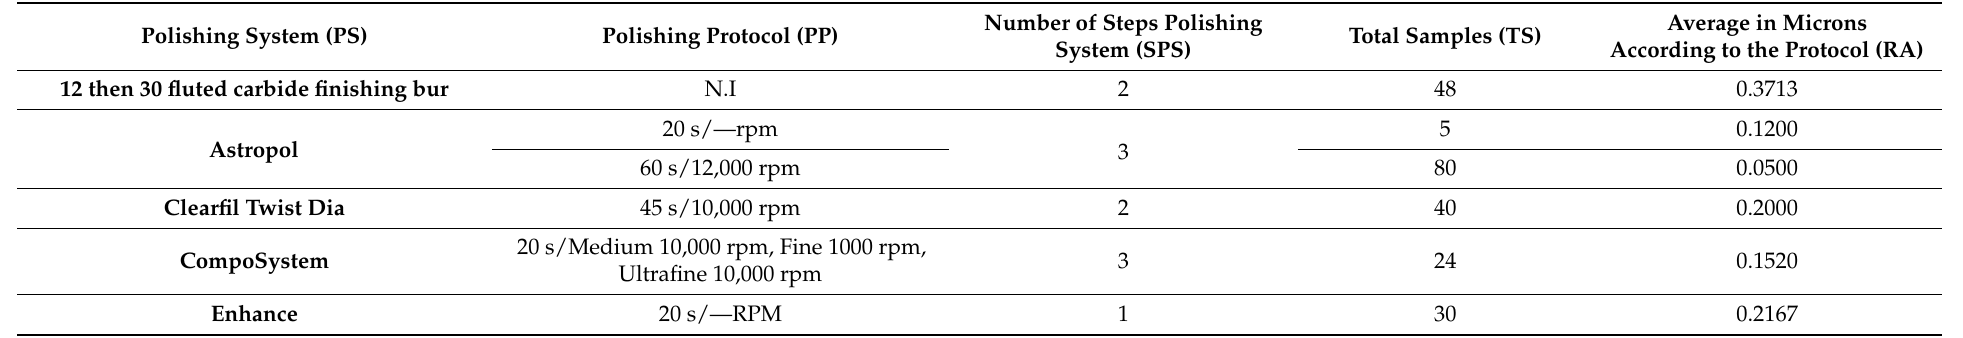
Table 3. Summary of the polishing protocols (PP) according to the studies provided in the systematic review (n = 17). Polishing System